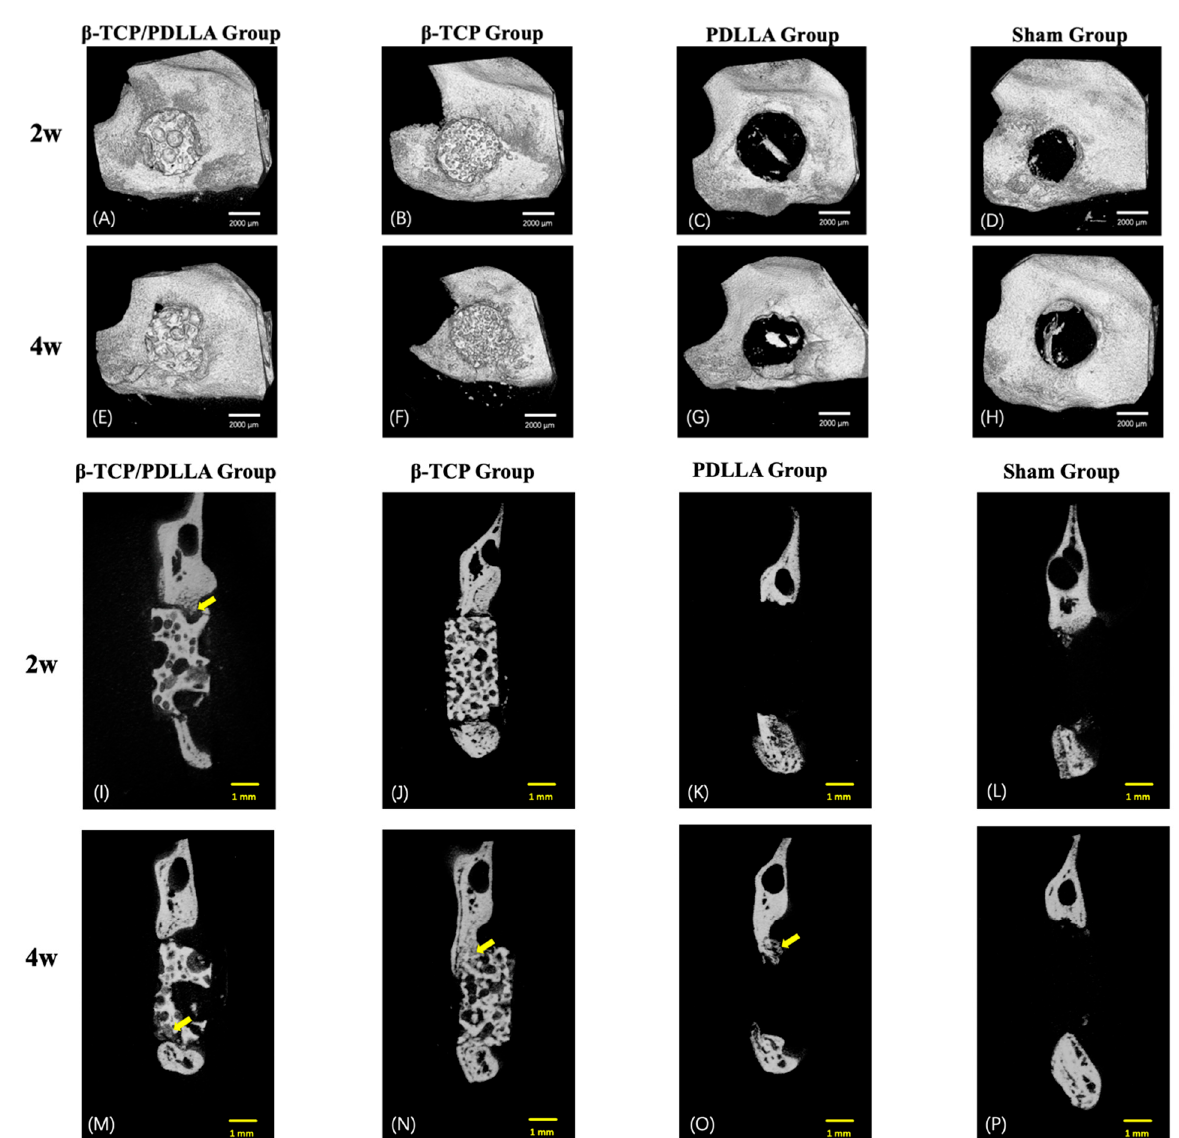
Figure 3. Micro-CT images of the mandible defects from the sagittal and coronal plane sections at 2 weeks ( A – D , I – L ; n = 3) and 4 weeks ( E – H , M – P ; n = 3). ( A , E , I , M ) Group 1: β -TCP/PDLLA group. ( B , F , J , N ) Group 2: β -TCP group. ( C , G , K , O ) Group 3: PDLLA group. ( D , H , L , P ) Group 4: sham group. The yellow arrows indicate the newly formed bone. Scale bars: 2000 μ m (white) and 1 mm (yellow).